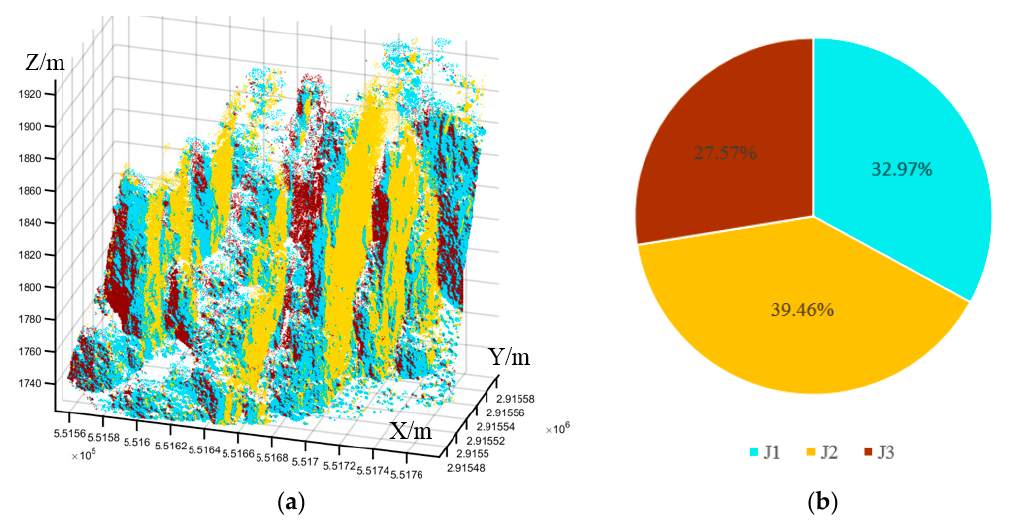
Figure 14. Clustering results of the discontinuous surface of the rock on the left side of the steep cliff: ( a ) clustering of rock discontinuities; the results show that there are three discontinuity sets. ( b ) The area share of each discontinuity set and the color it